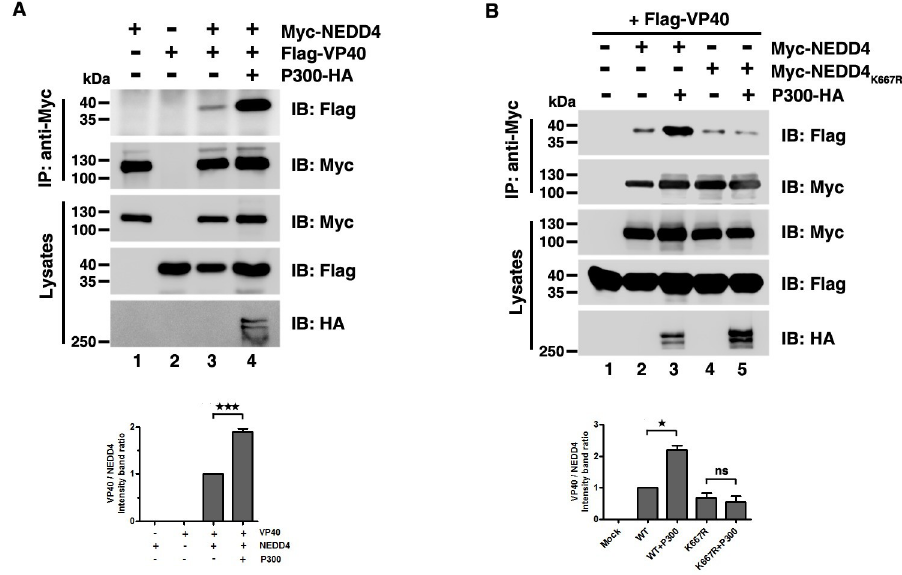
Fig 4. Acetylation enhances NEDD4-VP40 interactions. (A)-(B) Interactions were assayed by overexpressing the indicated plasmid combinations to determine the influence of P300 on VP40 -NEDD4 interaction or VP40- NEDD4 K667R interaction. Error bars, mean ± SD of three experiments. Student’s t test; � p < 0.05; �� p < 0.01; ��� p < 0.001.